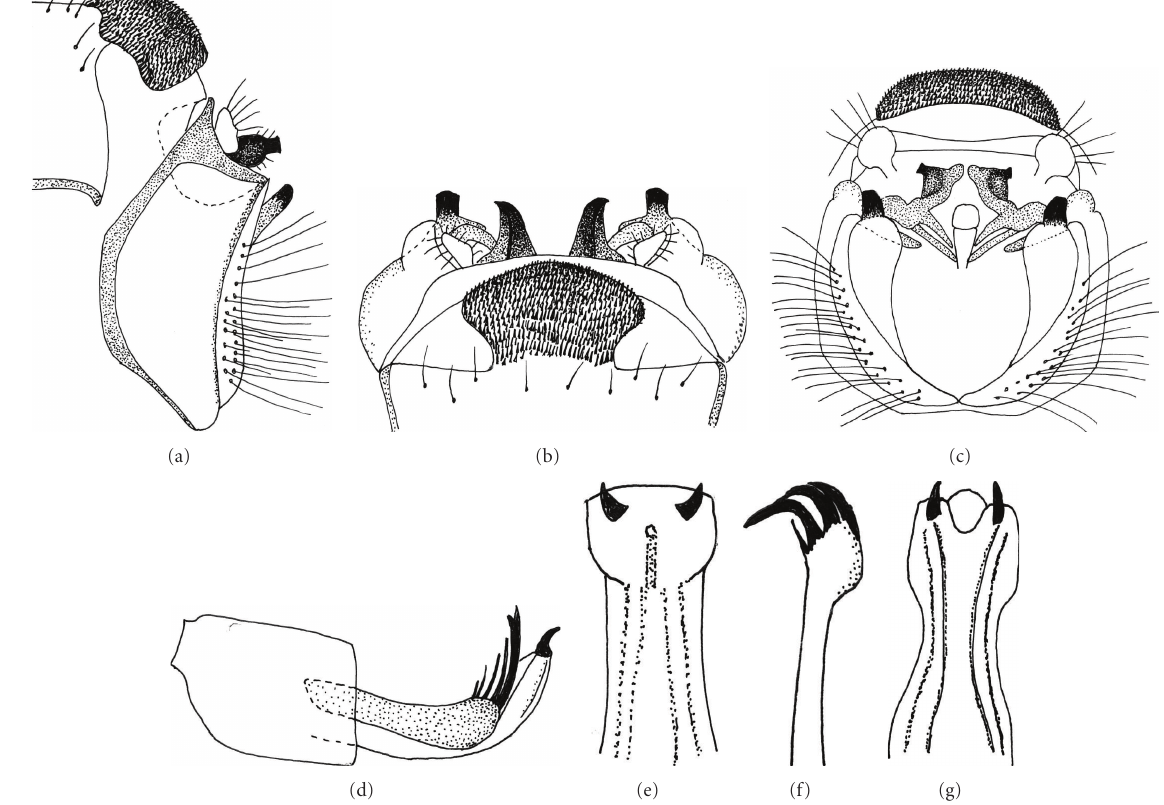
Figure 3: Chaetopteryx sinopica sp.n., male genitalia: (a) lateral; (b) dorsal; (c) caudal; (d) phallic apparatus, lateral; (e) phallic apparatus, dorsal, (f) left paramere, dorsal; (g) phallic apparatus,